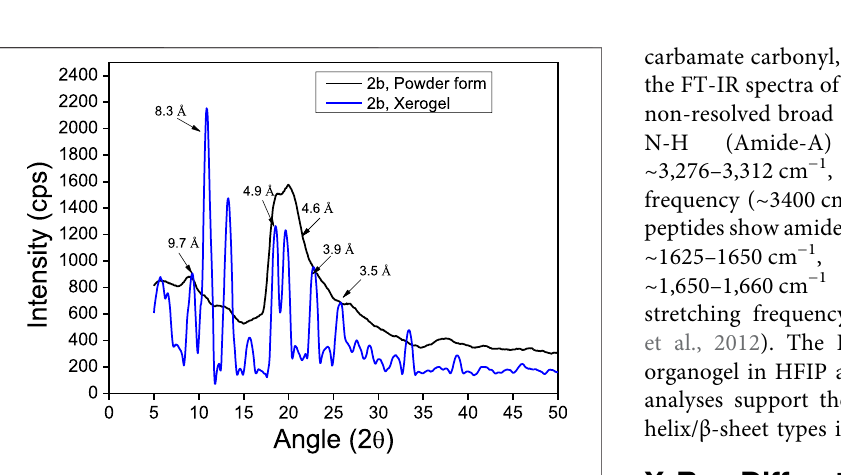
FIGURE 7 | Powdered XRD re fl ection pattern of APA-peptide 2b